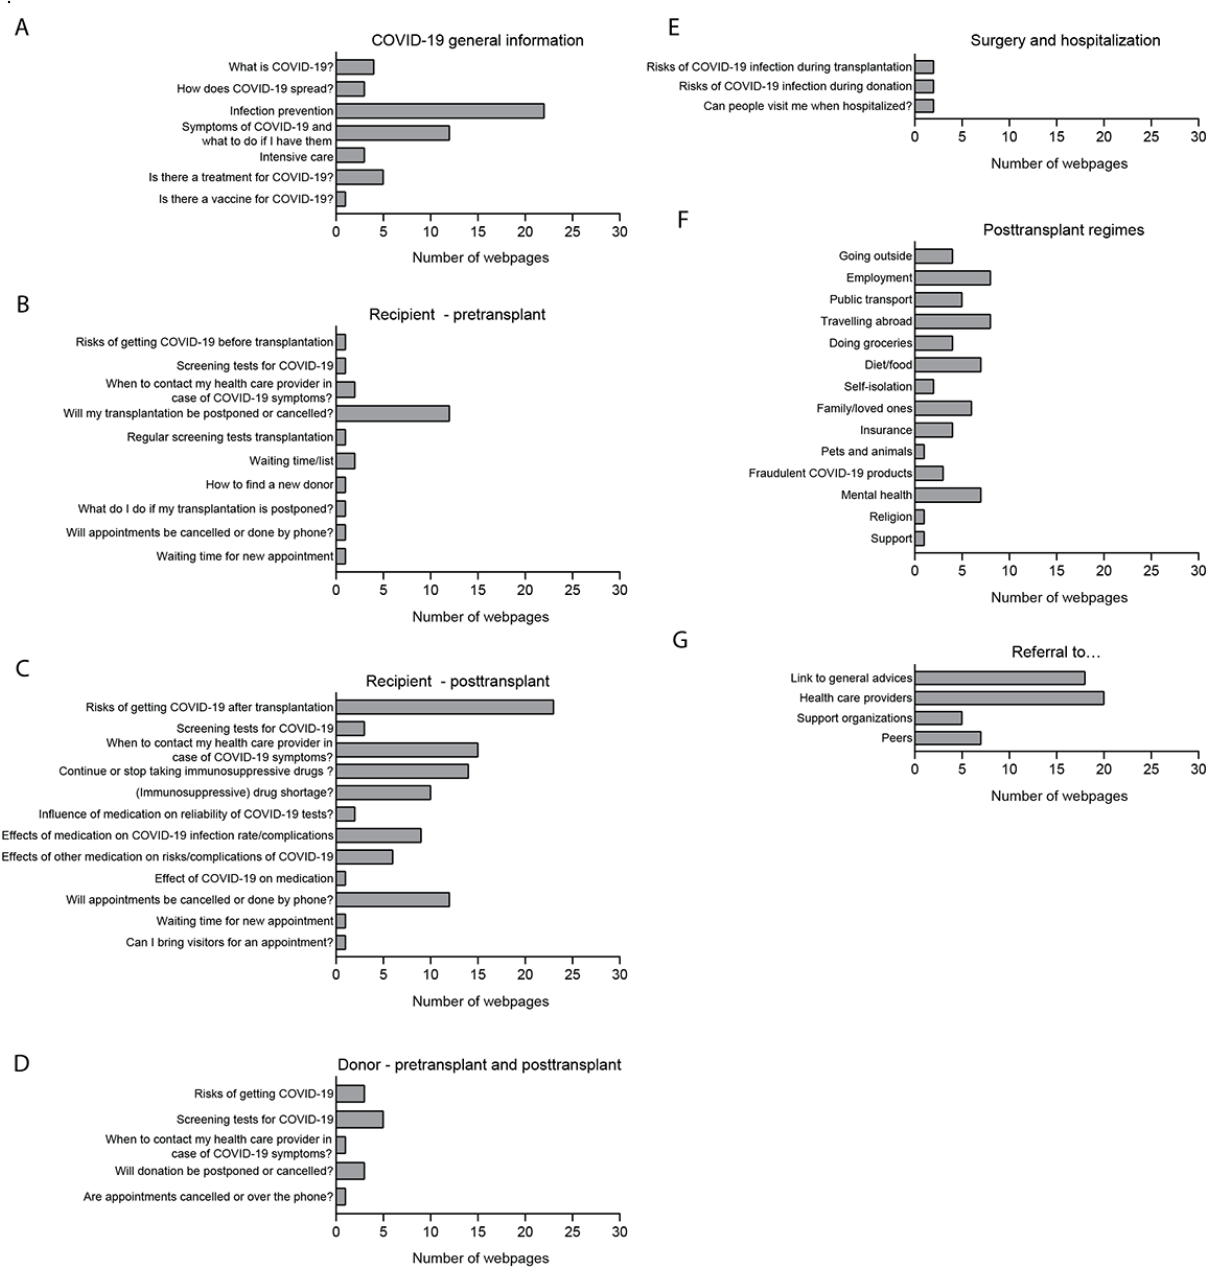
Figure 2. Numbers of webpages discussing content topics regarding COVID-19 for patients undergoing renal transplant and living donors. The webpages per included website that discussed the content topics were categorized in 7 main themes: (A) COVID-19 general information, (B) recipient–pretransplant, (C) recipient–posttransplant, (D) donor–pretransplant and posttransplant, (E) surgery and hospitalization, (F) posttransplant regimens, and (G) referral